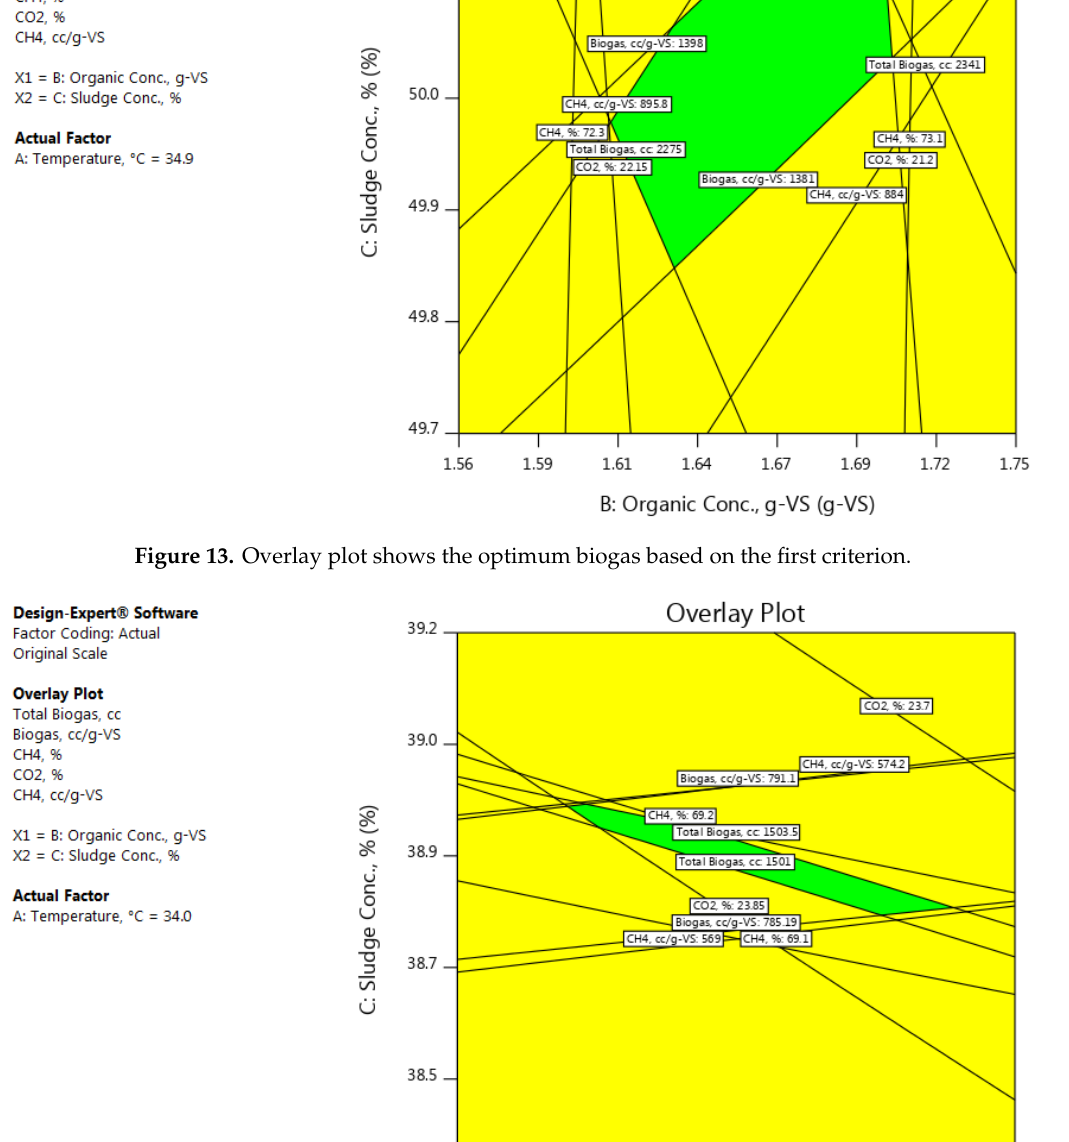
Figure 15. Overlay plot shows the optimum biogas based on the third criterion. 3.4. Energy Balance Figure 16 shows the average electric energies consumed at each temperature level. As is evident from Table 10, the highest energy gain by the g-VS/0.2 L of potato peels reached was 62.9% at 35 °C (A), 1.62 g-VS/0.2 L (B) and 50% (C). In other words, based on the three criteria, the production of the biogas from 1 g-VS/0.2 L of potato peels was at its highest level at the above setting, 62.9% higher energy than that consumed in its production. According to the table, the highest energy gain in terms